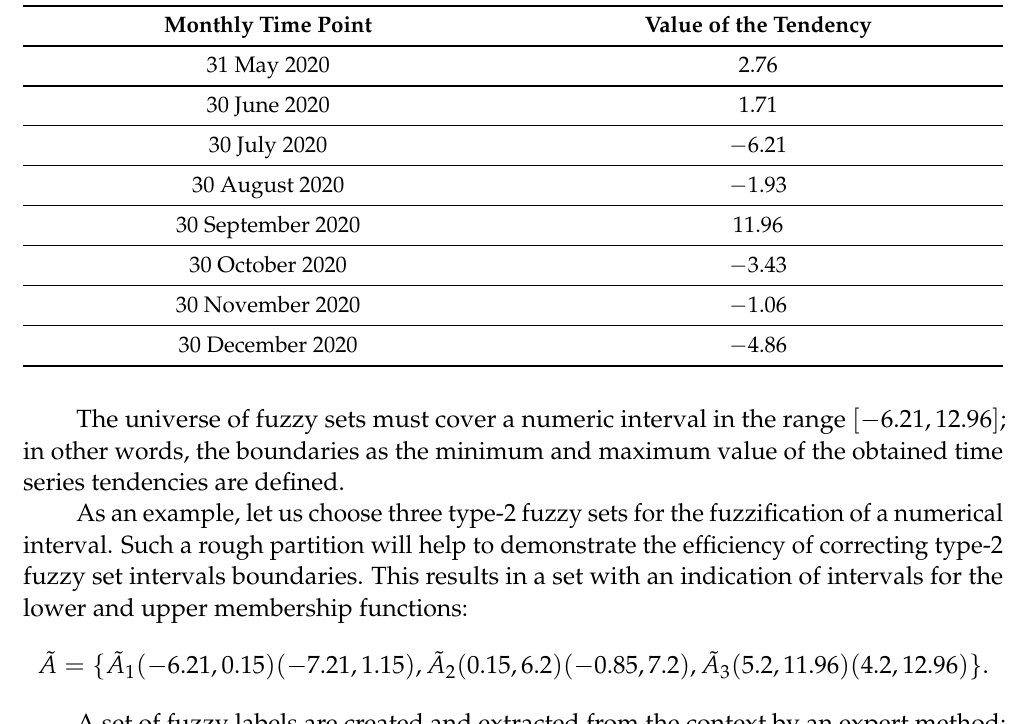
Table 2. Time series